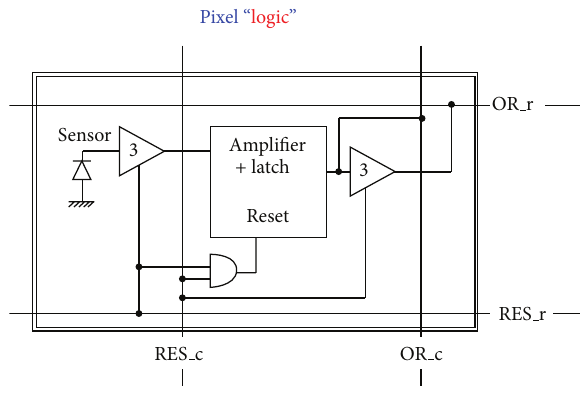
Figure 7: The 4-wire pixel logic.